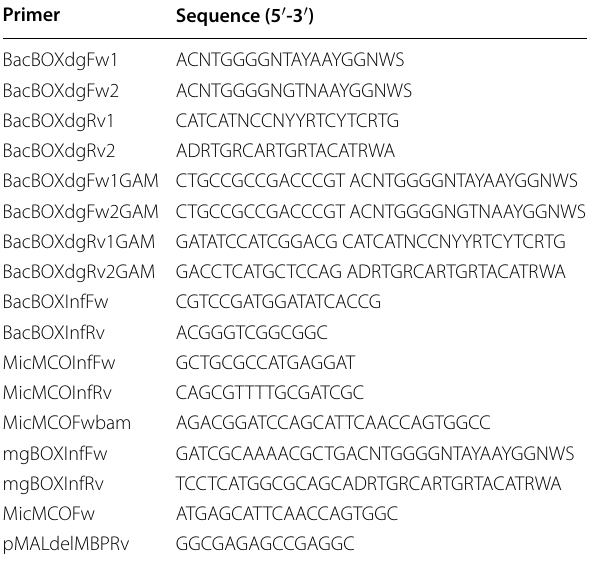
Table 1 PCR primers for isolating the core genes of MCO from